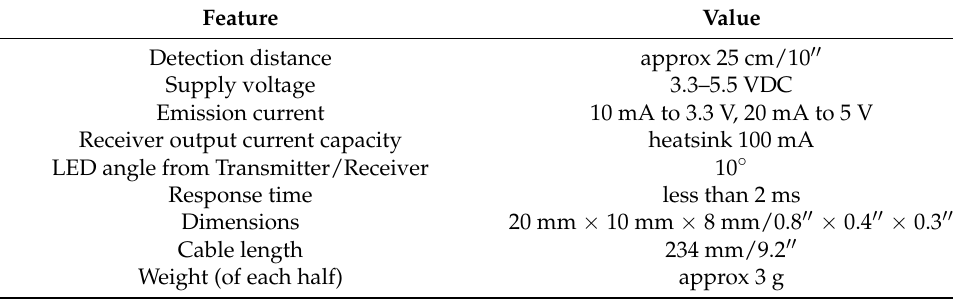
Table 1. Specifications of the break beam